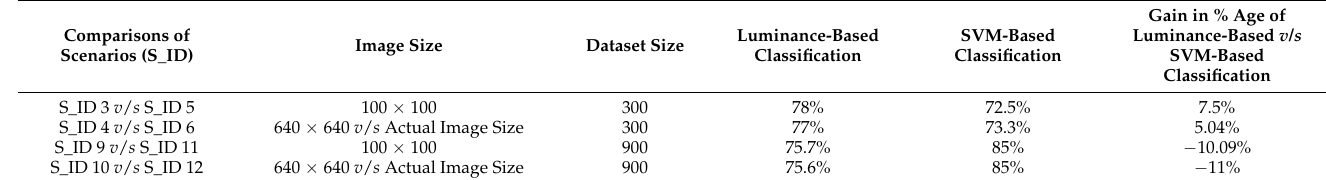
Table 7. Gain Analysis of RPLC Algorithm over SVM